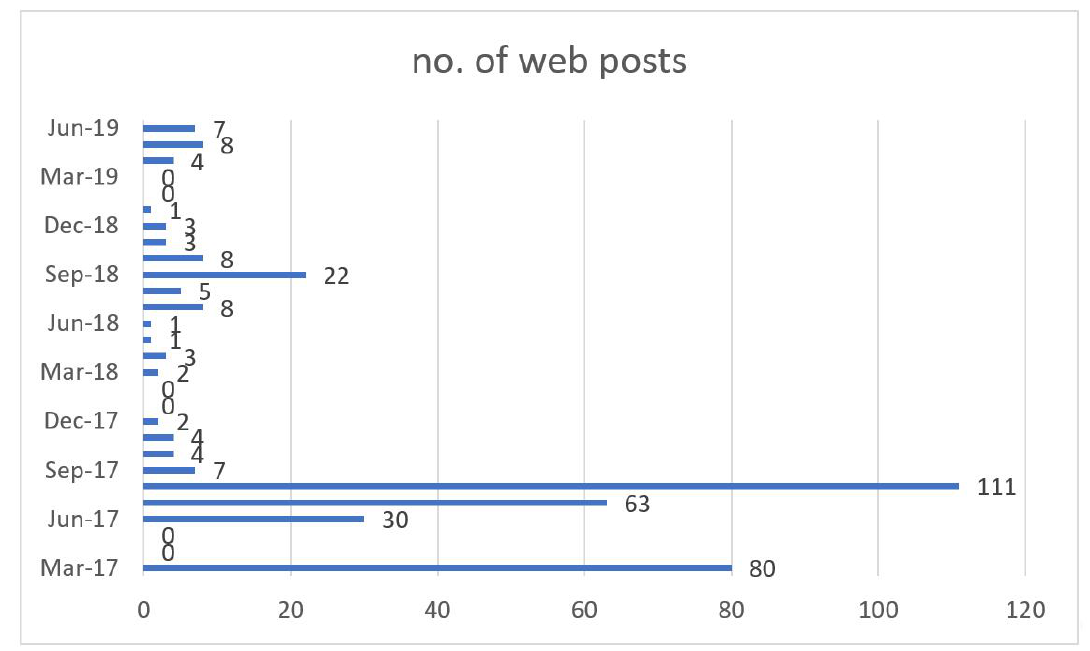
Figure 2. Number of oBike-related web